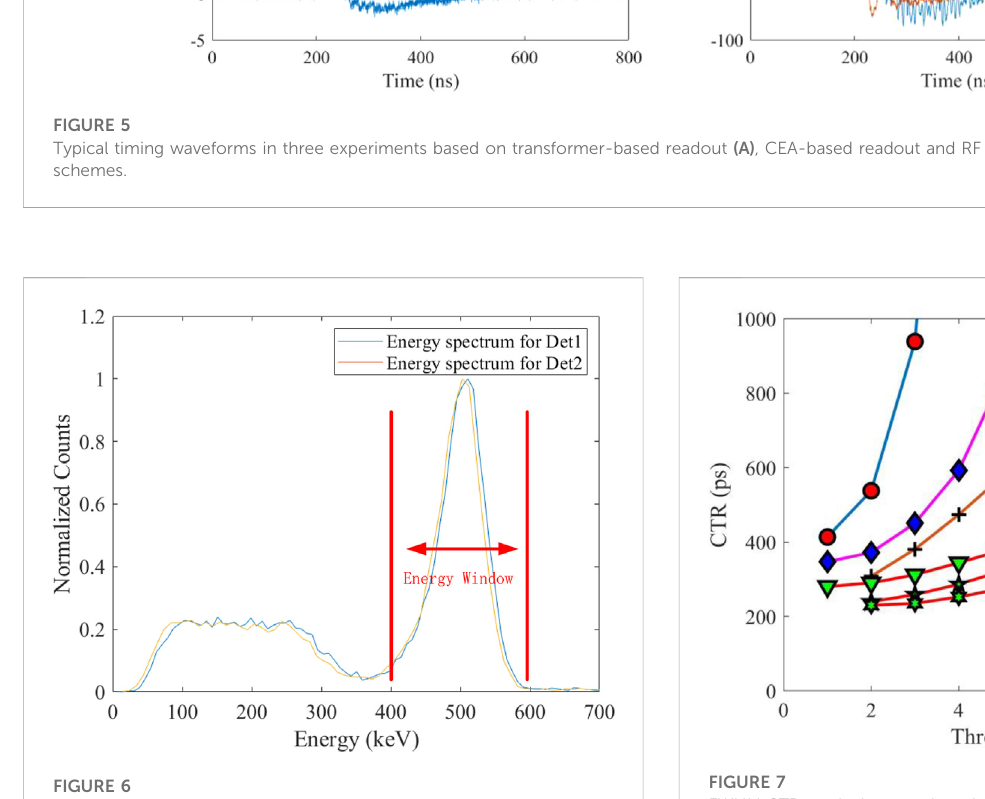
Typical energy spectra for Det1 and Det2 respectively. FWHM CTR results by scanning trigger thresholds when the SiPMs are biased at different